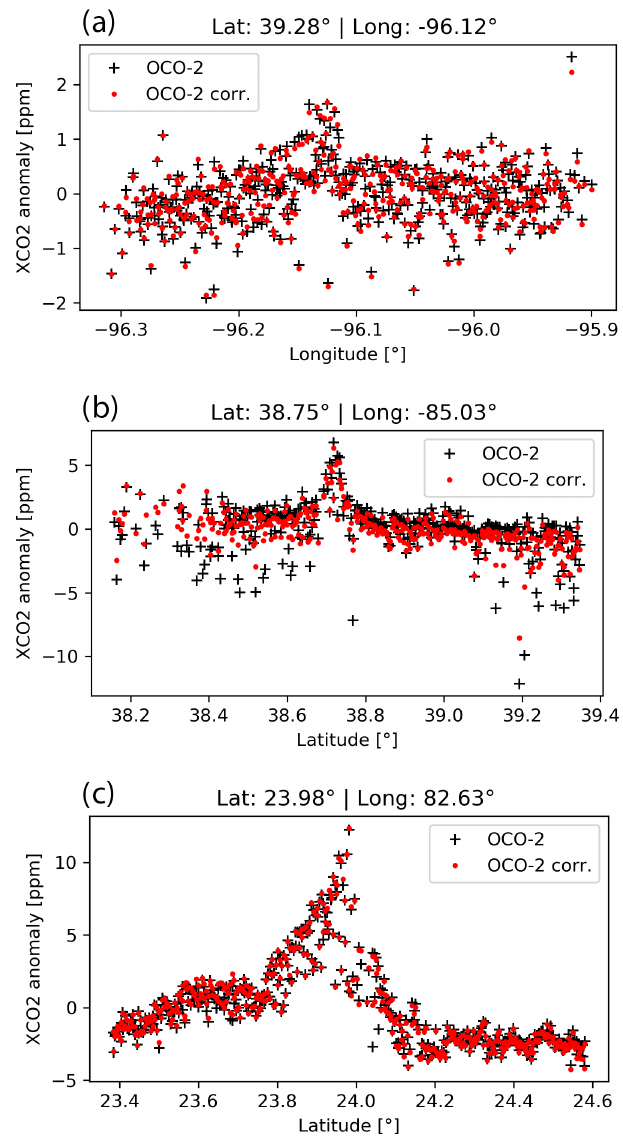
Figure 11. X CO anomalies for OCO-2 and bias-corrected OCO- 2 2 retrievals in the proximity of coal power plants. Power plant (a) Westar at lat 39.28 ◦ , long − 96 . 12 ◦ , on 4 December 2015; (b) Ghent at lat 38.75 ◦ , long − 85 . 03 ◦ , on 13 August 2015; and (c) Sasan at lat 23.98 ◦ , long − 82 . 63 ◦ , on 23 October 2014. Anomaly is calculated by subtracting the